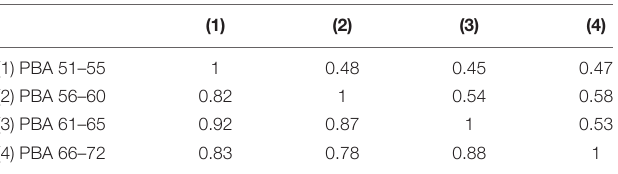
TABLE 3 | Predicted brain age additive genetic (below diagonal) and non-shared environmental correlations based on the best fitting “AE” 1-factor common pathway